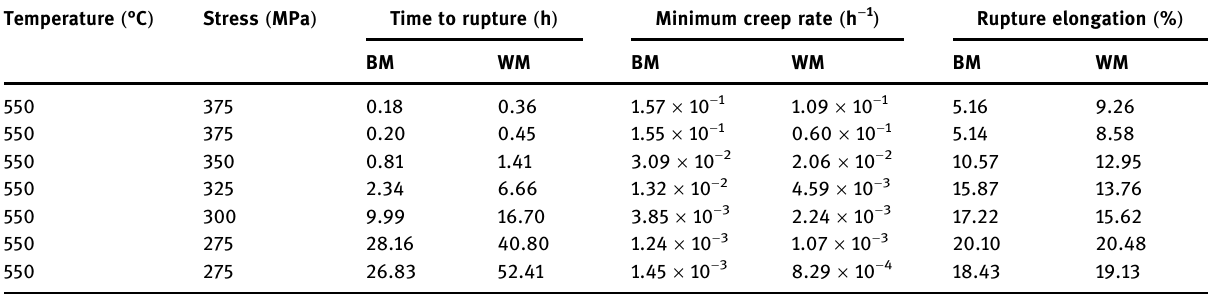
Table 4: Summary of creep - rupture time, minimum creep rate, and rupture elongation of BM and WM in 2.25Cr1Mo0.25V steel welded joint Temperature ( °C